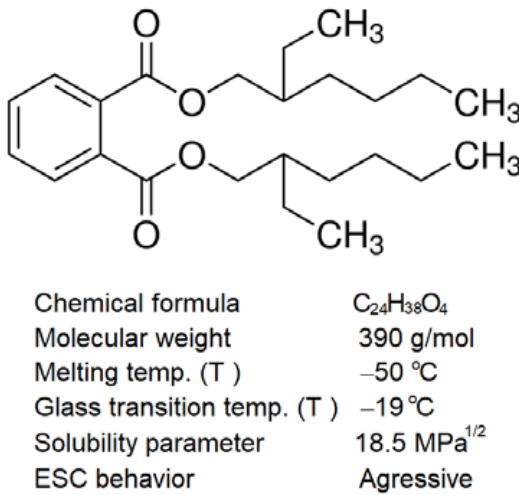
Figure 1. Molecular structure and properties of dioctyl phthalate (DOP) oil.